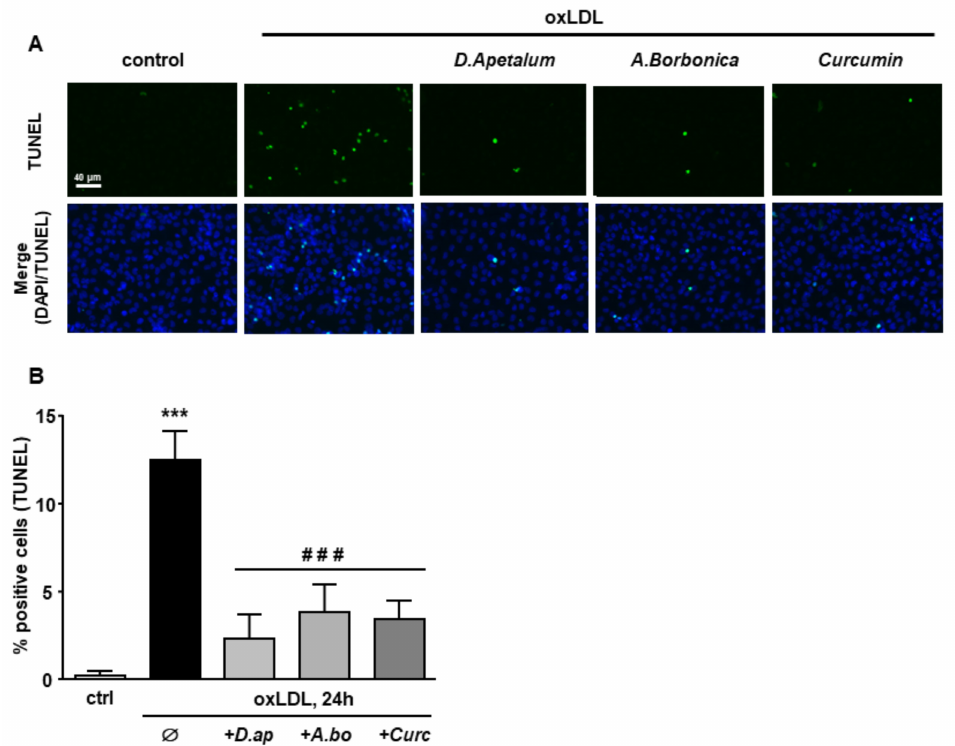
Figure 7. D. apetalum and A. borbonica extracts limit oxLDL-induced DNA fragmentation. Subconflu- ent serum-starved HMEC-1 cells were preincubated for 2 h with D. apetalum (25 µ M), A. borbonica (25 µ M) polyphenol-rich extracts or curcumin (10 µ M) before addition of oxLDLs (200 µ g apoB/mL) for an additional 24 h. ( A ) Analysis of DNA fragmentation by TUNEL assay in HMEC-1 cells (green). Cell nuclei are stained with DAPI (blue). Scale bar = 40 µ m; ( B ) graph represents percentage of TUNEL- positive cells. Results are expressed as means ± SEM of 3 independent experiments; *** p < 0.001 vs. control (ctrl); ### p < 0.001 vs. oxLDL using one-way ANOVA with Tukey’s posthoc